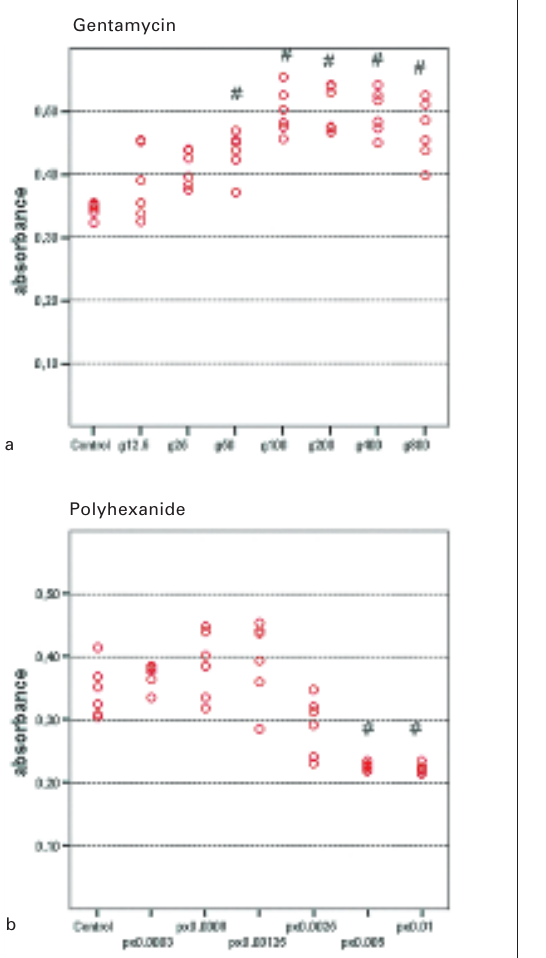
Figure 2 Effect of a) gentam- icin and b) polyhexa- nide on human foetal osteoblasts cell viability. Effect of c) gentamicin and d) polyhexanide on human foetal os- teoblast cell number (g = gentamicin, px = polyhexanide, # p <0.05 versus